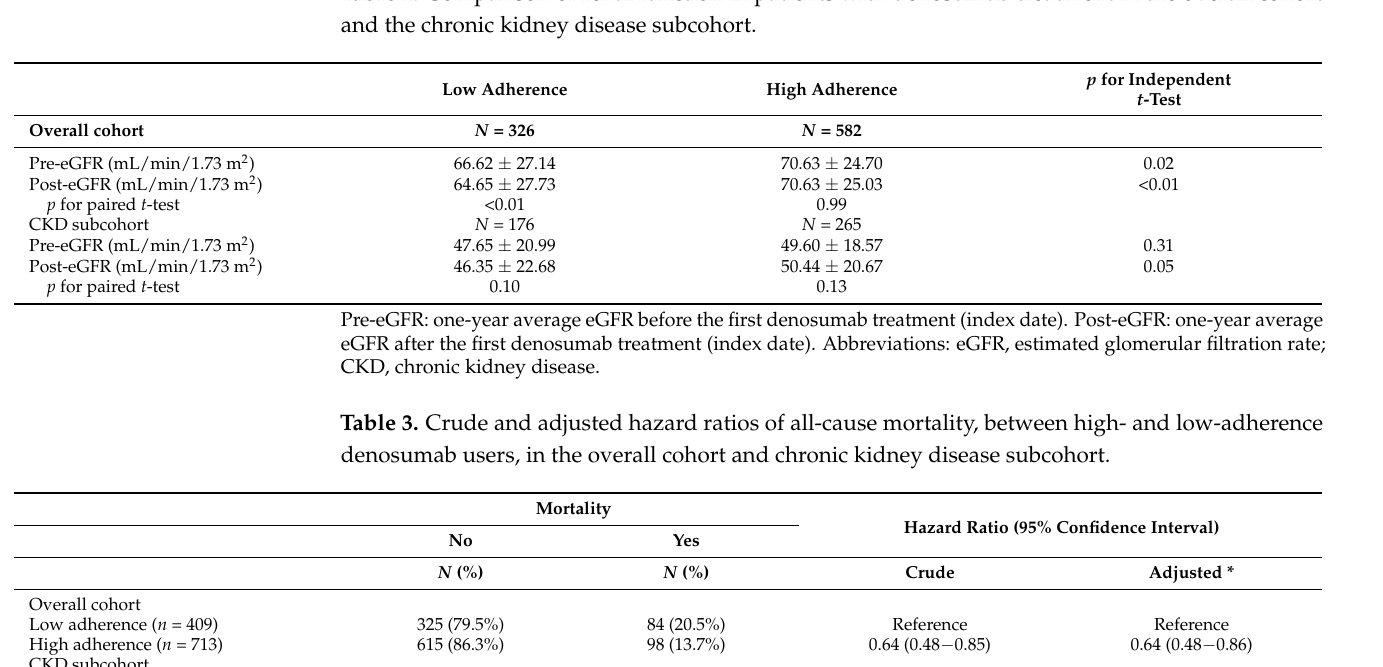
* Adjusted for age, gender, and Charlson comorbidity index score. Abbreviations: CKD, chronic kidney